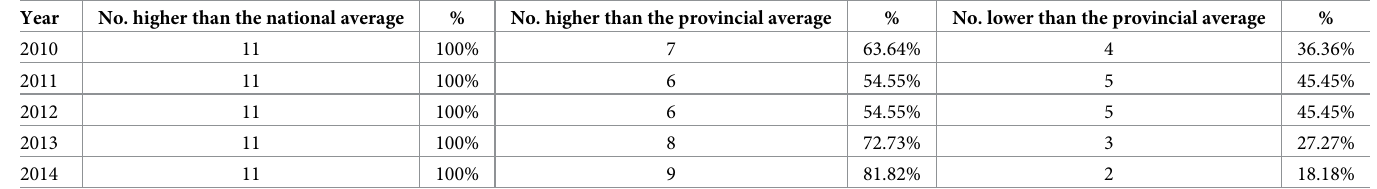
Source: compared and calculated by the ecological civilization construction level between Jiangxi and the